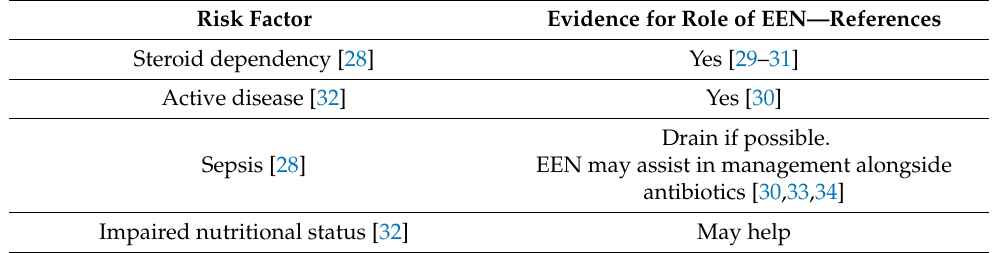
Table 1. Key risk factors for